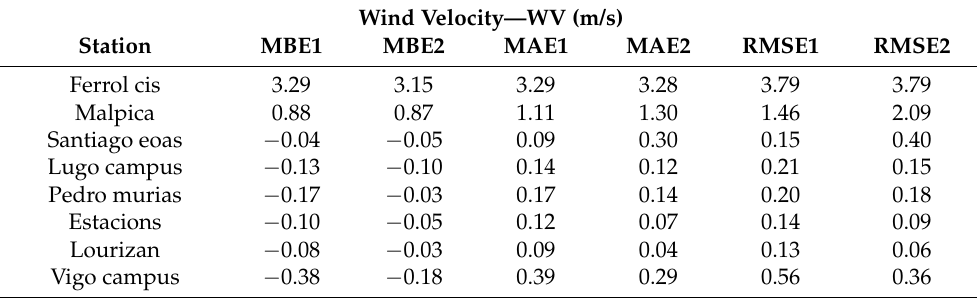
Table A4. WV error statistics for the 8